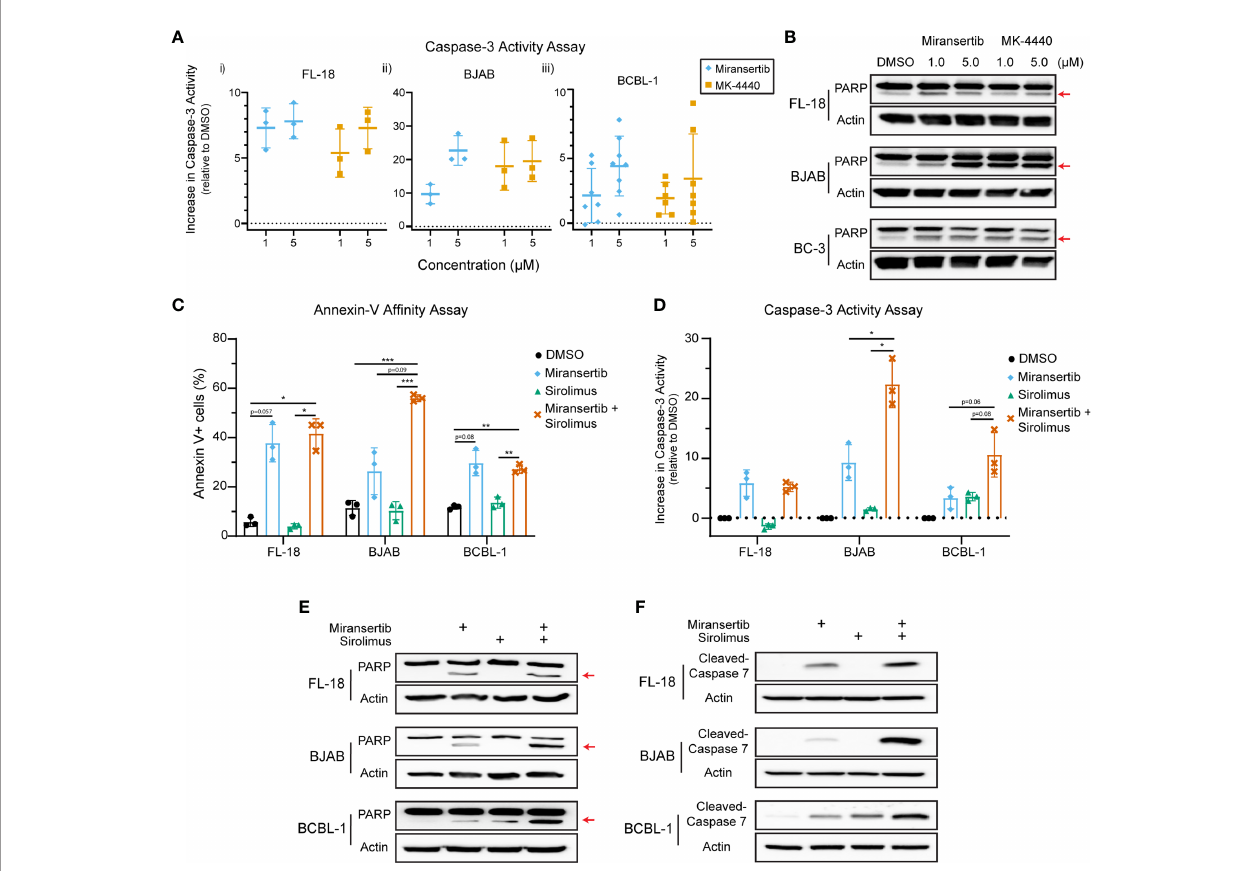
FIGURE 7 | Inhibition of Akt by miransertib or MK-4440 induces apoptosis in non-Hodgkin lymphoma cell lines. (A) FL-18 (i), BJAB (ii), and BCBL-1 (iii) cells were treated for up to 72 h with DMSO, miransertib, or MK-4440 at the indicated concentrations. The level of caspase-3 activity following the drug treatment was measured using the ApoAlert Caspase-3 Fluorescent Assay, and the results were graphed as a dot plot representing the increase in activity compared to DMSO (activity = 0). (B) FL-18, BJAB, and BC-3 cells were treated for 72 h with DMSO, miransertib, or MK-4440 at the indicated concentrations. Immunoblots were performed to detect the levels of PARP and the loading control b -actin. The red arrow points to cleaved PARP. (C) FL-18, BJAB, and BCBL-1 cells were treated for 48 h with vehicle, miransertib (5 µM for BJAB and BCBL-1, and 10 µM for FL-18), sirolimus (10 nM) or the combination of the Akt and mTORC1 inhibitor at the indicated concentrations. The percentage of annexin V+ cells was determined by staining cells with annexin V-FITC and propidium-iodide (PI) followed by fl ow cytometry analysis. The mean ± STD of 3 experiments is depicted in the bar graph. *p < 0.05; **p < 0.01; ***p < 0.001 determined by one-way ANOVA. (D) FL-18, BJAB, and BCBL-1 cells were treated for 48-72 h with vehicle, miransertib (1 µM for BJAB and BCBL-1, and 5 µM for FL-18), sirolimus (10 nM) or the combination of the Akt and mTORC1 inhibitor at the indicated concentrations. The caspase-3 assays were performed as in panel (A) The mean ± STD of 3 experiments is depicted in the bar graph. *p < 0.05 determined by Welch ’ s t-test. (E) FL-18, BJAB, and BCBL-1 cells were treated for 48 h with DMSO, miransertib (5 µM for BJAB and BCBL-1, and 10 µM for FL-18), sirolimus (5 nM), or the combination of both inhibitors. Immunoblots were performed to detect the levels of PARP and the loading control b -actin. The red arrow points to cleaved PARP. (F) FL-18, BJAB, and BCBL-1 cells were treated as in (E) , and immunoblots were performed for cleaved-caspase 7 and the loading control b